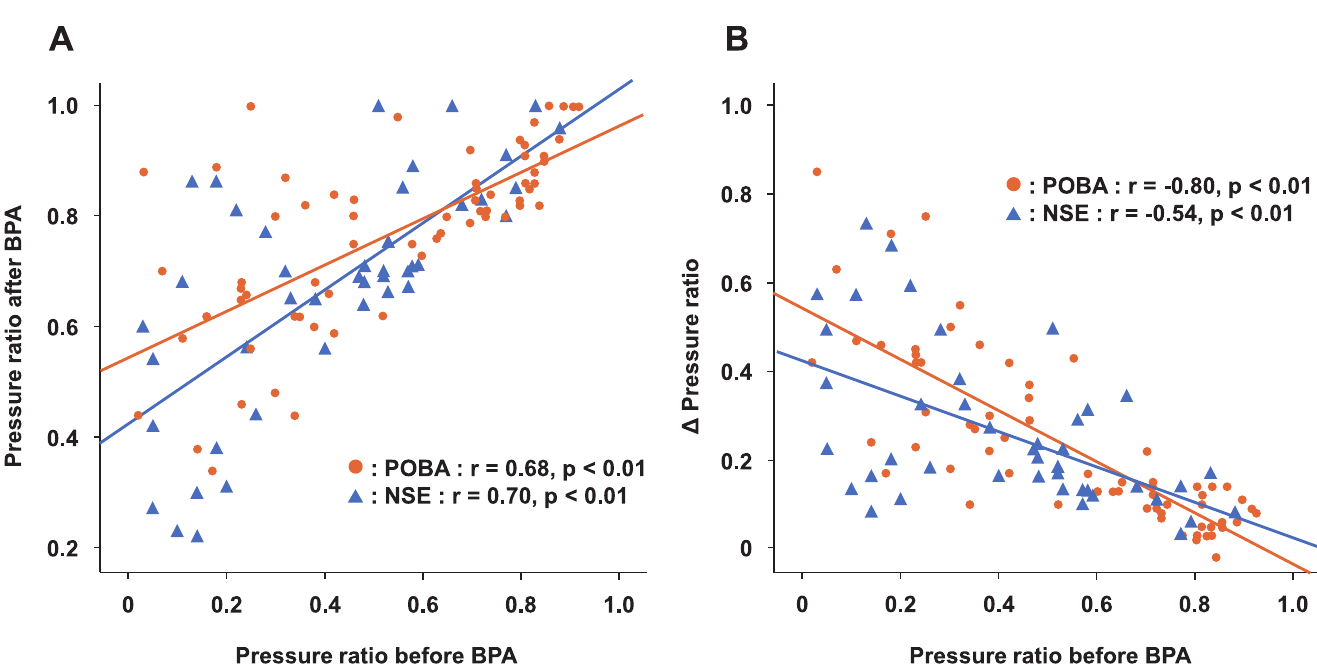
Fig 3. The relationship between pressure ratio before and after balloon pulmonary angioplasty (BPA). Pressure ratio before BPA and pressure ratio after BPA plot (A), pressure ratio before BPA and Δ Pressure ratio plot (B).